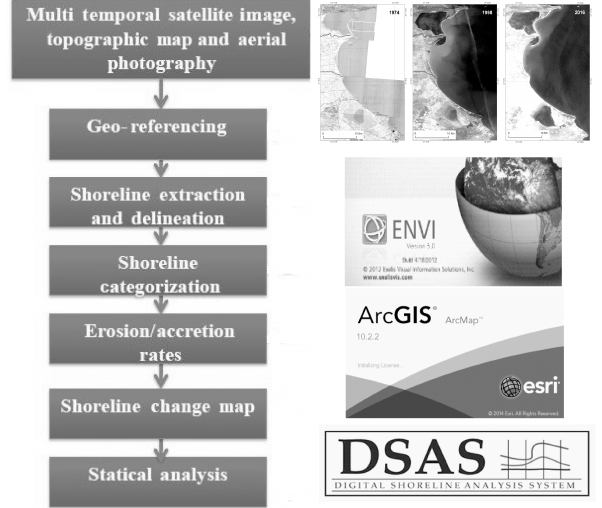
Figure 2. The workflow of methodology.